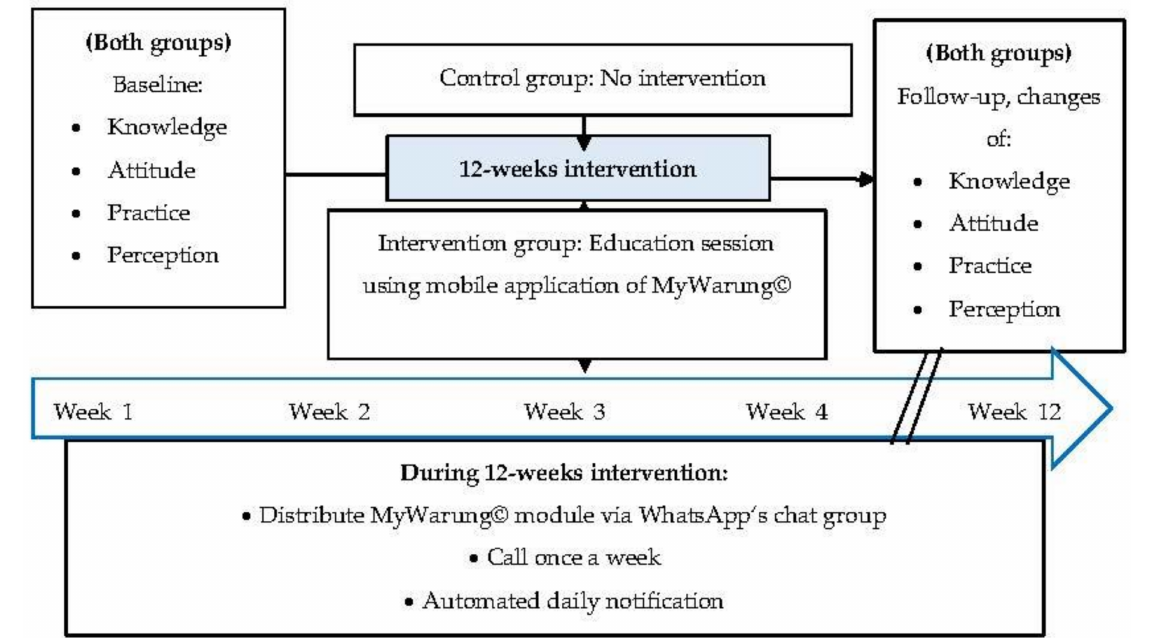
Figure 5. Setting and schedule of the